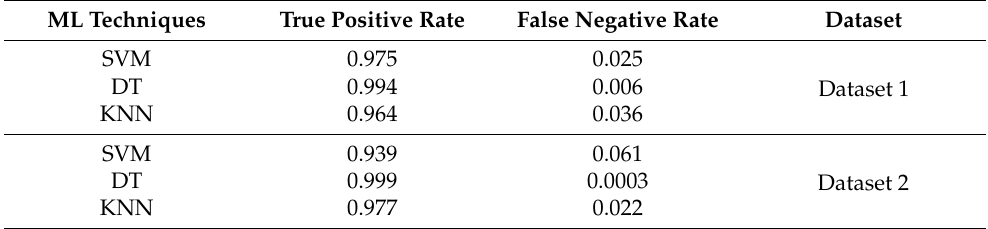
Table 10. Variation of true positive and false negative